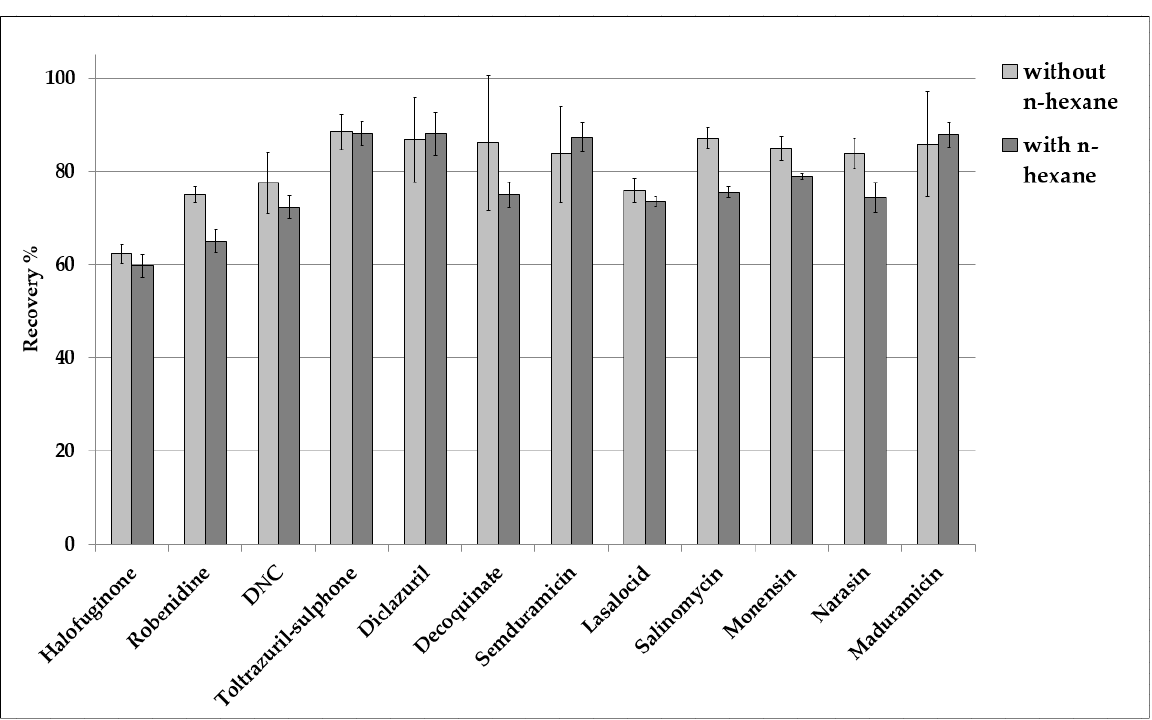
Figure 2. Recoveries derived by different clean-up approaches in egg samples ( n = 4 per experiment) spiked at 33.3 µg kg − 1 .